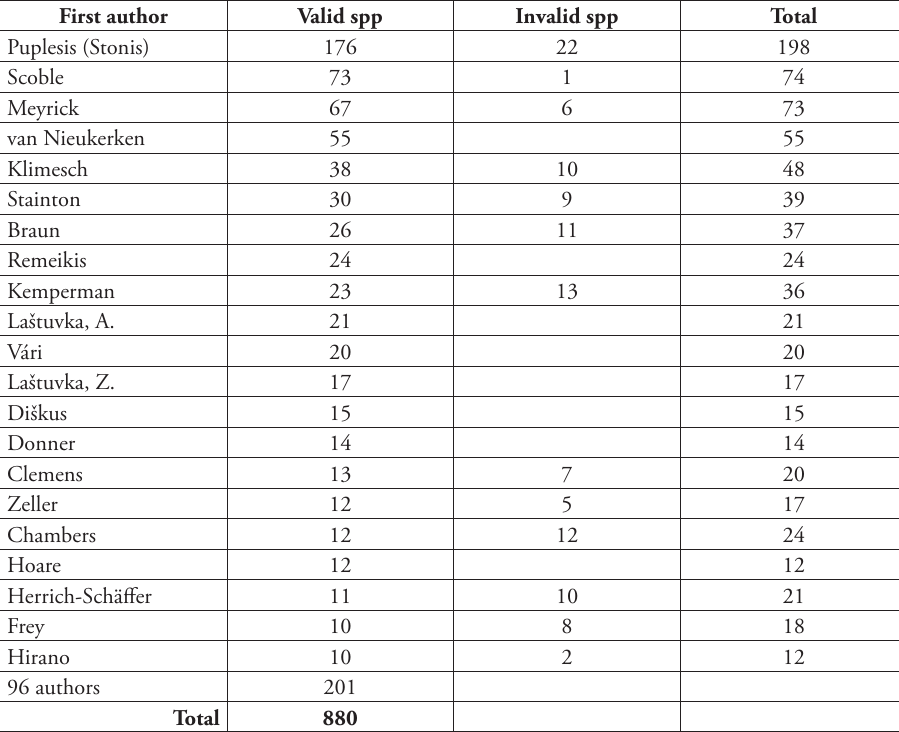
Table 1. Number of Nepticulidae species (valid and invalid) described per first author for authors who described at least ten valid species, including extant and fossil